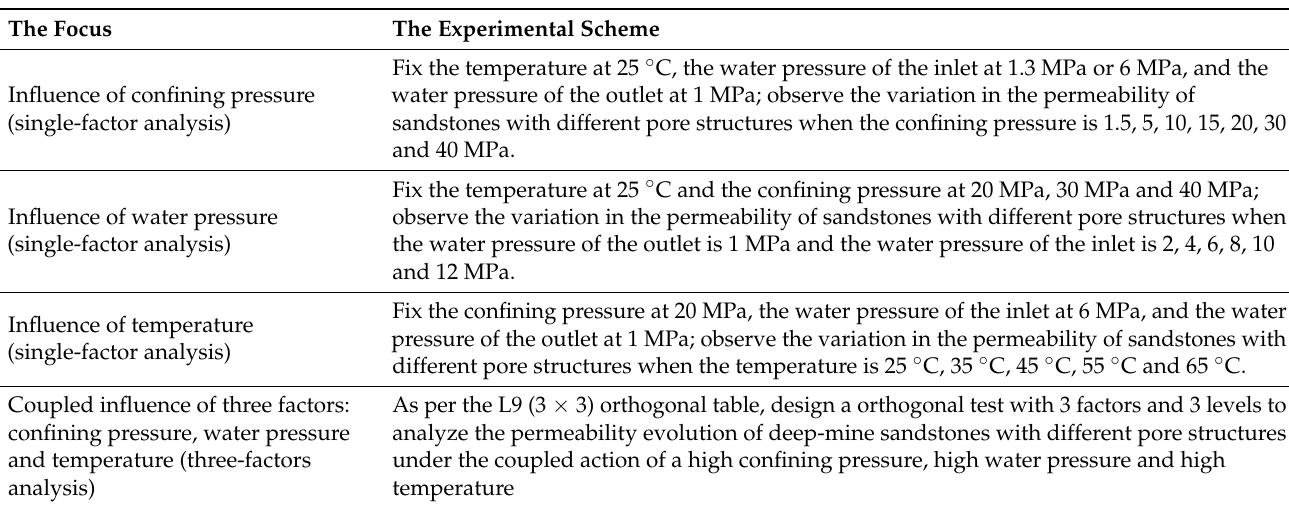
The Experimental